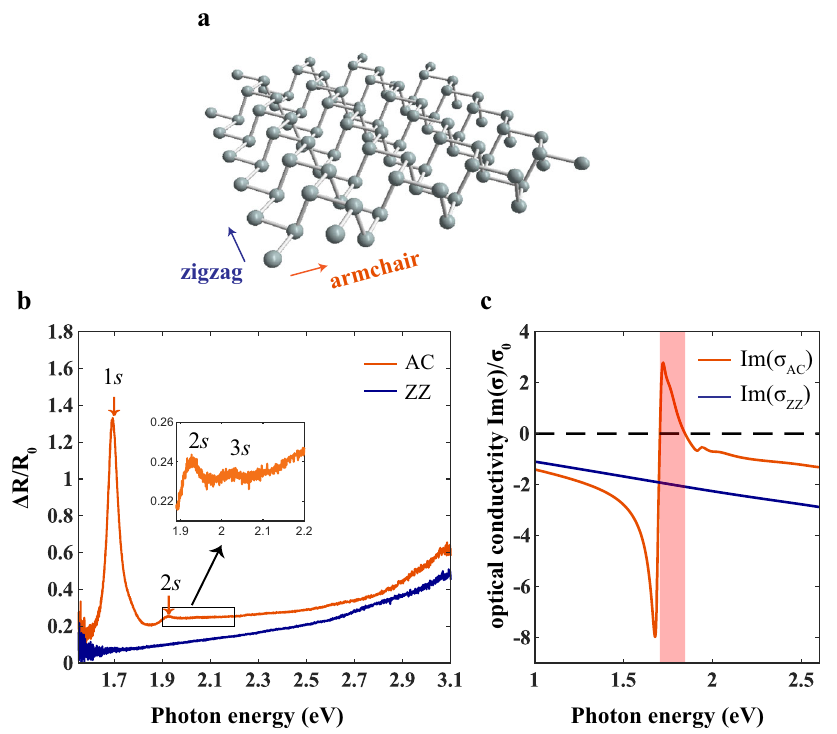
Fig. 2 Exciton properties in monolayer BP. a Schematic illustration of the crystal structure of monolayer BP. b Re fl ection contrast spectra of monolayer BP, with light polarized along with armchair (AC) and zigzag (ZZ) direction. The 1 s , 2 s and 3 s excitonic states are found at ~1.69, ~1.92, and ~2.04 eV, respectively. Inset: a zoom-in for the 2 s and 3 s resonance peaks. c The extracted imaginary part of the optical conductivity along with armchair and zigzag directions in the unit of σ 0 ¼ e 2 = 4 _ . The black dashed line at zero is a guide to the eyes. The highly anisotropic optical conductivity renders a HEP regime from 1.703 – 1.844 eV, as marked by the pink area, where Im ð σ AC Þ(cid:2) Im ð σ ZZ Þ <